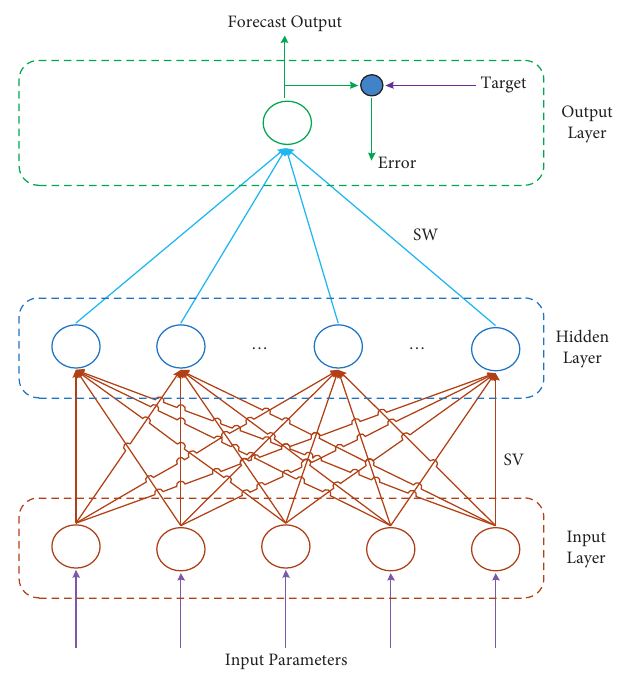
Figure 4: Structural design of